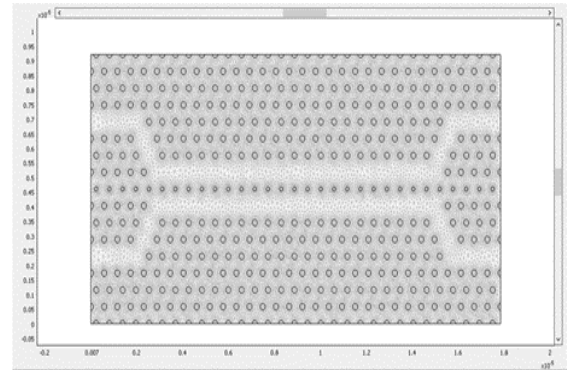
Figure 5 (a): Dielectric rectangular as meshed in an FDTD grid.